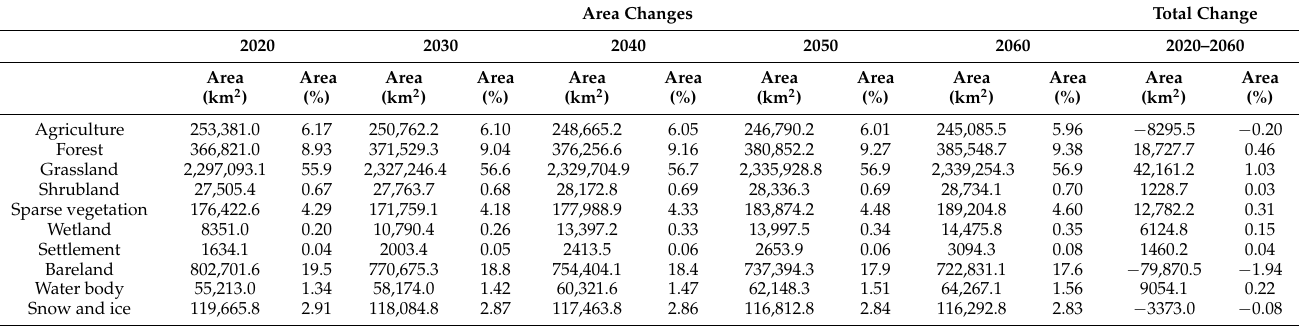
Figure 6. Predicted land-cover maps in ( a ) 2030; ( b ) 2040; ( c ) 2050; ( d ) 2060. Table 3. Shows a decadal prediction of land-cover changes in the Third Pole from 2020 to 2060. Area